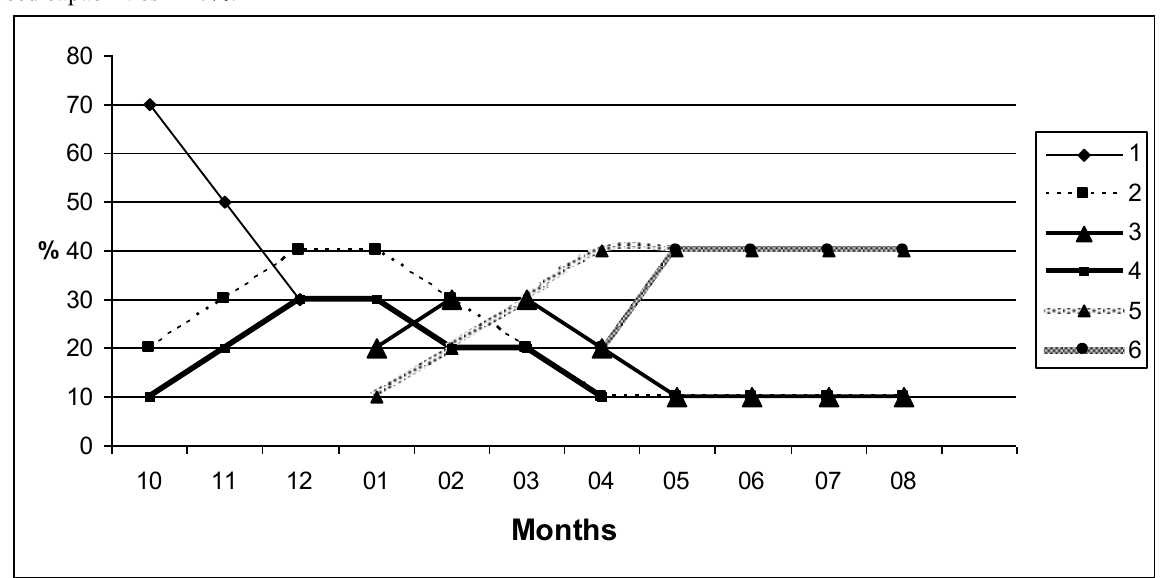
Fig. 1. Plan-chart of special physical preparation of experimental